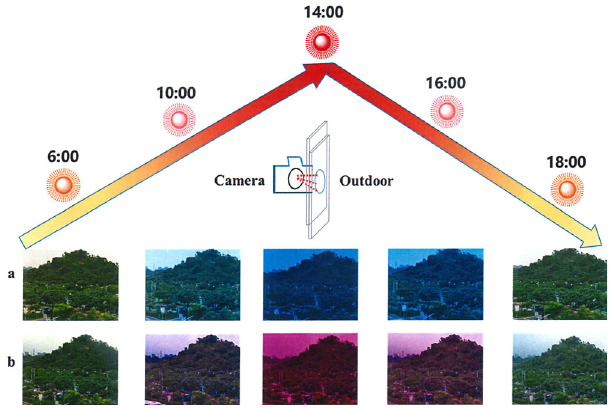
Fig. 5 Automatic light adjustment of PSC-powered ECDs in real-time. Digital images of outdoor sceneries viewed through PSC-powered ECDs by blocking device on the lens of the camera at different times ( a : DPV; b : MPV).